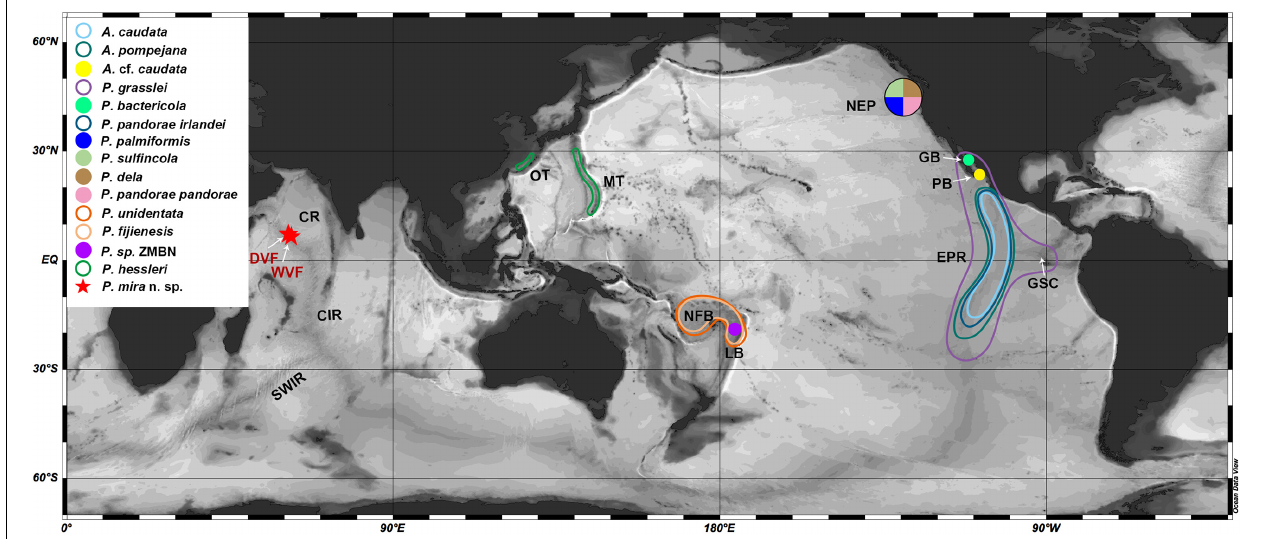
FIGURE 1 | A map showing the known distributions of alvinellids. Specie names coded as different symbol shown in the inset. Abbreviations: DVF, Daxi Vent Field; WVF, Wocan Vent Field; CR, Carlsberg Ridge; CIR, Central Indian Ridge; SWIR, Southwest Indian Ridge; OT, Okinawa Trough; MT, Mariana Trough; NFB, North Fiji back-arc Basin; LB, Lau back-arc Basin; NEP, Northeast Pacific; GB, Guaymas Basin; PB, Pescadero Basin in the southern Gulf of California; EPR, East Pacific Rise; GSC, Galapagos Spreading Center.